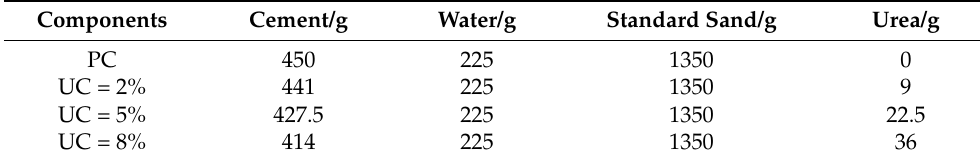
Table 3. Mix proportion of three groups of 40 mm × 40 mm × 160 mm concrete test